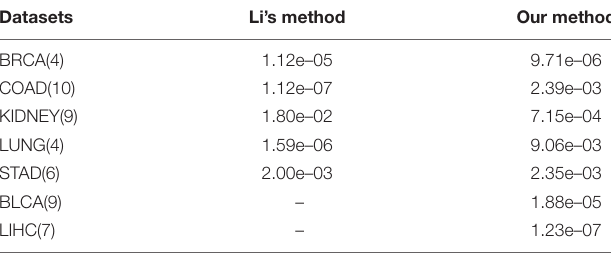
TABLE 4 | Performance between Li’s and our method.